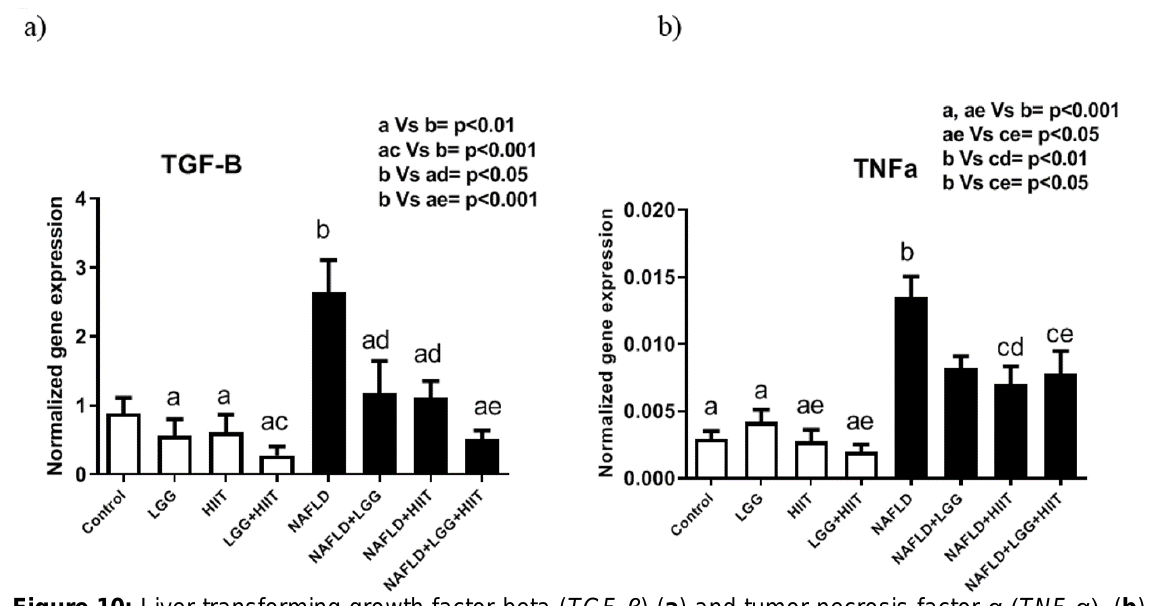
Figure 10: Liver transforming growth factor beta ( TGF - β ) ( a ) and tumor necrosis factor-α ( TNF -α), ( b ) mRNA expression in different groups of study. All values are the mean ± SD (n = 10 per group). Values with different superscripts are significantly different, p < 0.05. LGG: Probiotic L . Rhamnosus GG , HIIT: High intensity interval training, NAFLD: Non-alcoholic fatty liver